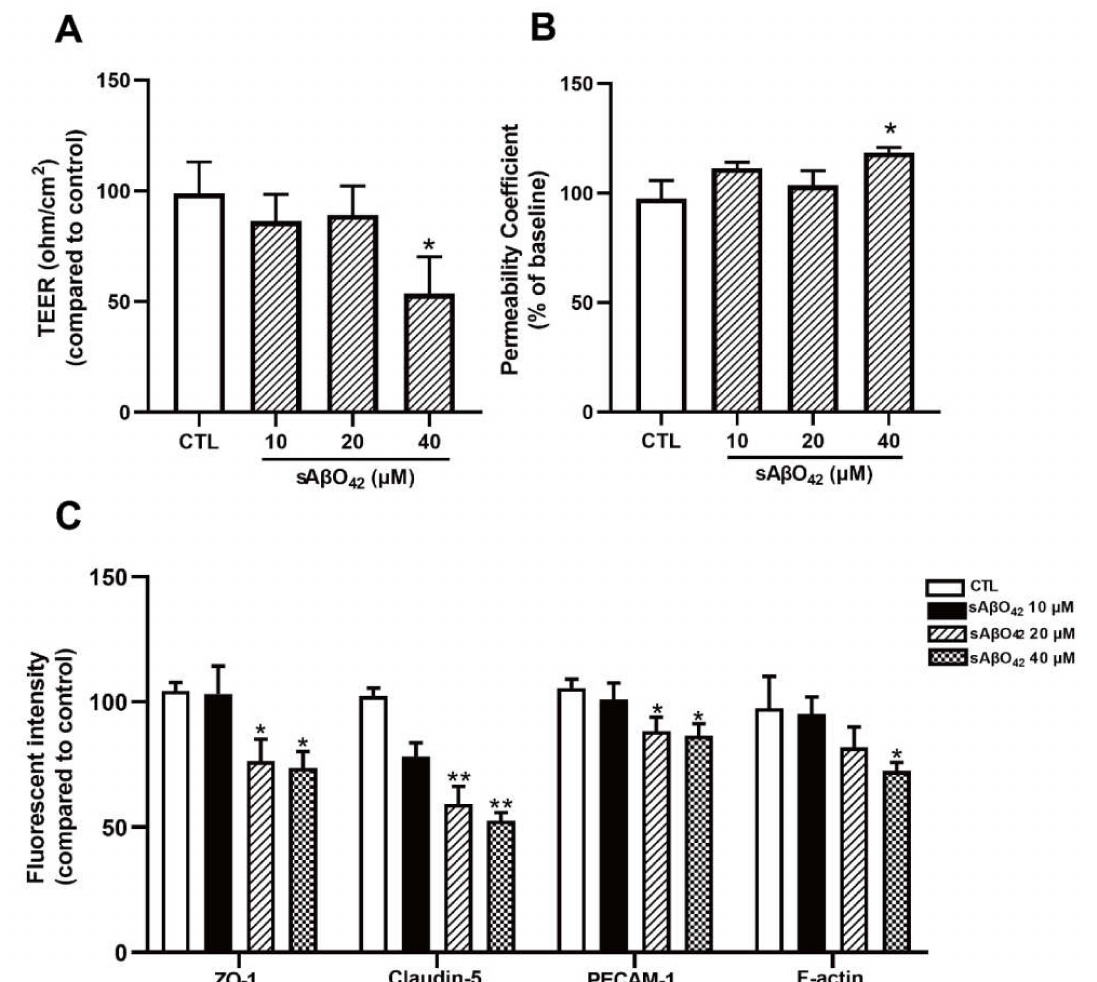
Figure 2. Murine sA β O42 exerted disruptive effects on the barrier function of the bEnd.3 monolayer up to 40 µ M. ( A ) Transendothelial electrical resistance (TEER) and ( B ) permeability of FITC-dextran across the bEnd.3 monolayer. ( C ) Fluorescent intensity of several junctional proteins (ZO-1, claudin-5, platelet and endothelial cellular adhesion molecule 1 (PECAM-1), and cytoskeleton protein F-actin) in bEnd.3 cells. Data are shown as means ± SD of at least three independent experiments and were analyzed by one-way ANOVA followed by a post hoc Dunnett’s test. * p ≤ 0.1, ** p ≤ 0.01, vs. control